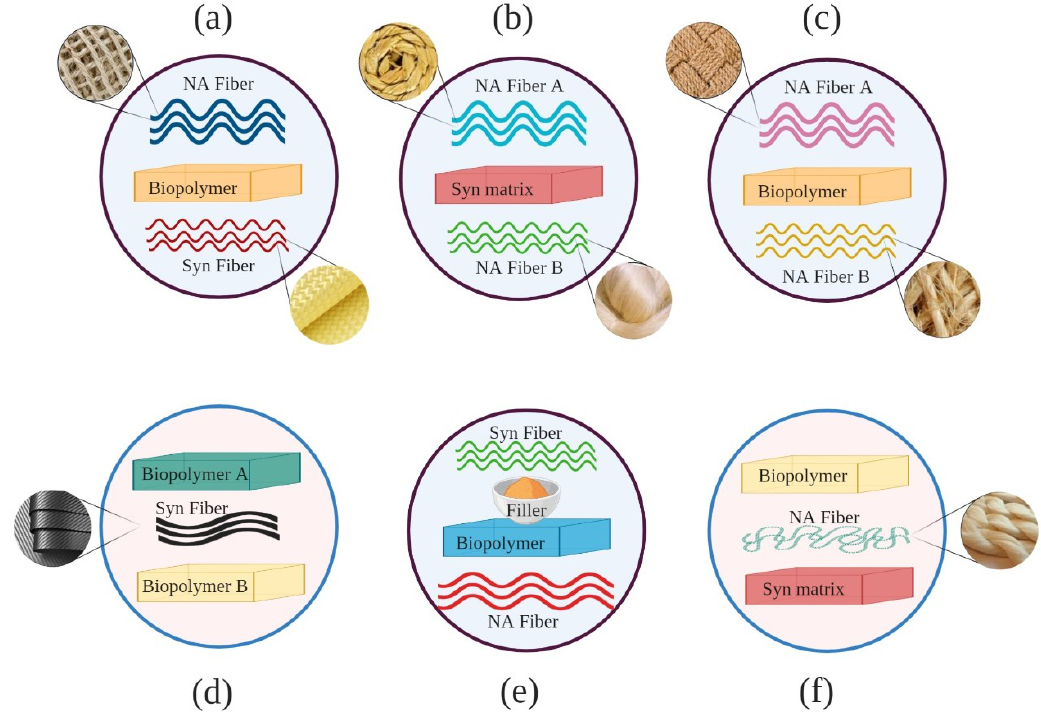
Figure 3. Some configurations of hybrid biocomposites (NA: natural, Syn: synthetic): ( a ) hybridization of natural and synthetic fibers with biopolymer matrix; ( b ) hybridization of two or more natural fibers with synthetic matrix; ( c ) hybridization of two or more natural fibers with biopolymer matrix; ( d ) hybridization of two or more biopolymer matrices with synthetic fiber; ( e ) hybridization of natural and synthetic fibers with fillers with biopolymer matrix ( f ) hybridization of biopolymer and synthetic matrices with natural fiber. [©MB, JA, MAM_UC3M2020].